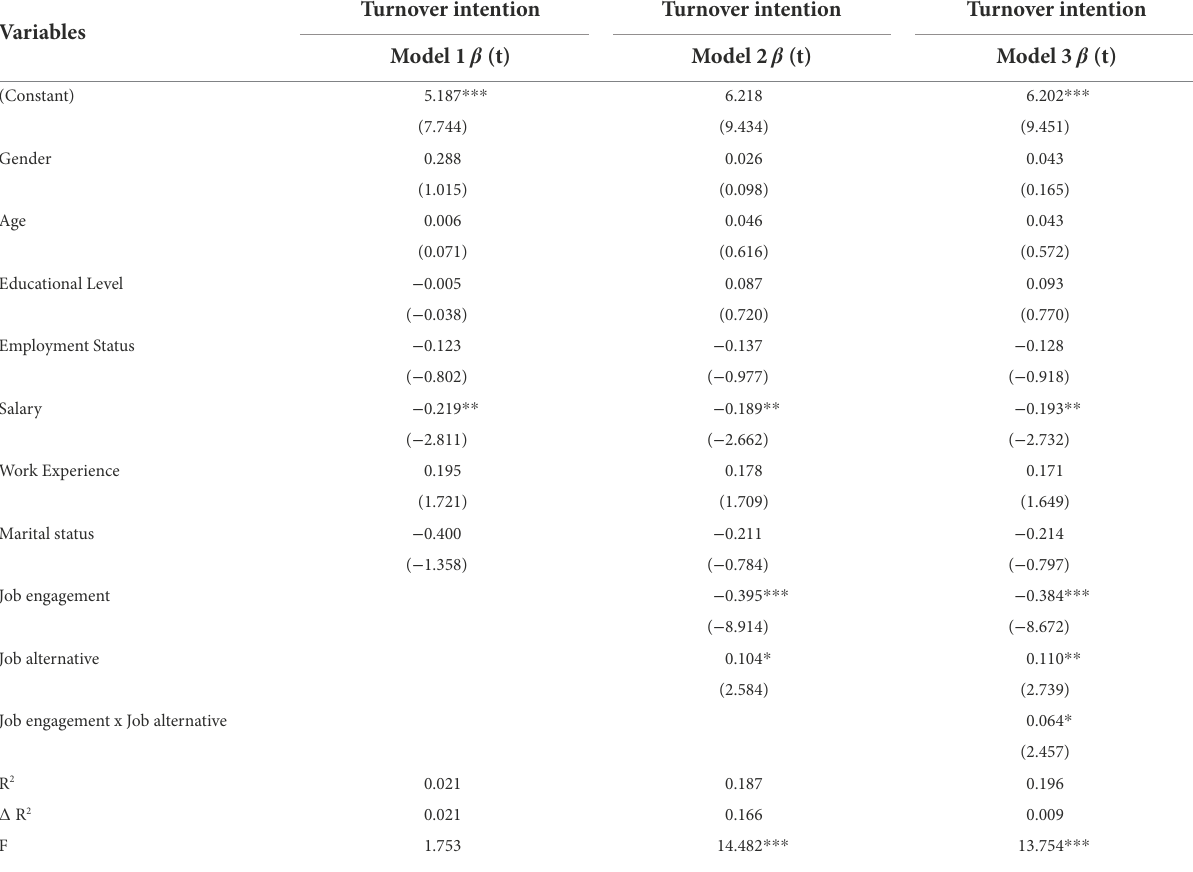
TABLE 5 Hierarchical regression results of the moderating effect of perceived job